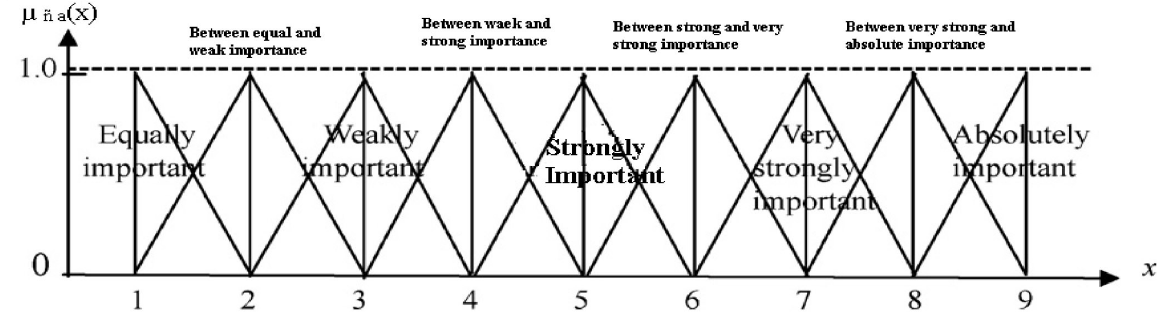
Figure 4. Membership function of linguistic variable for comparing two hazard